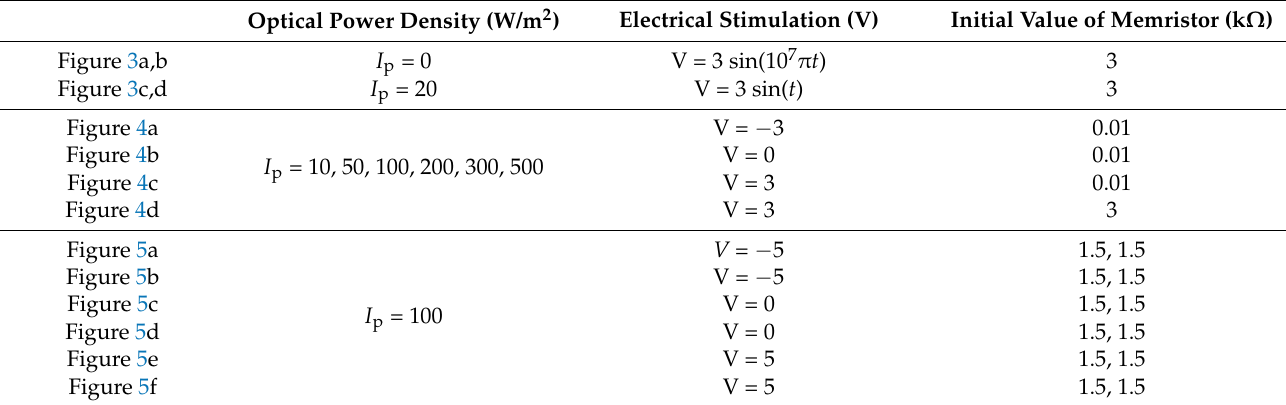
Table 3. Parameters for the electrical characteristics